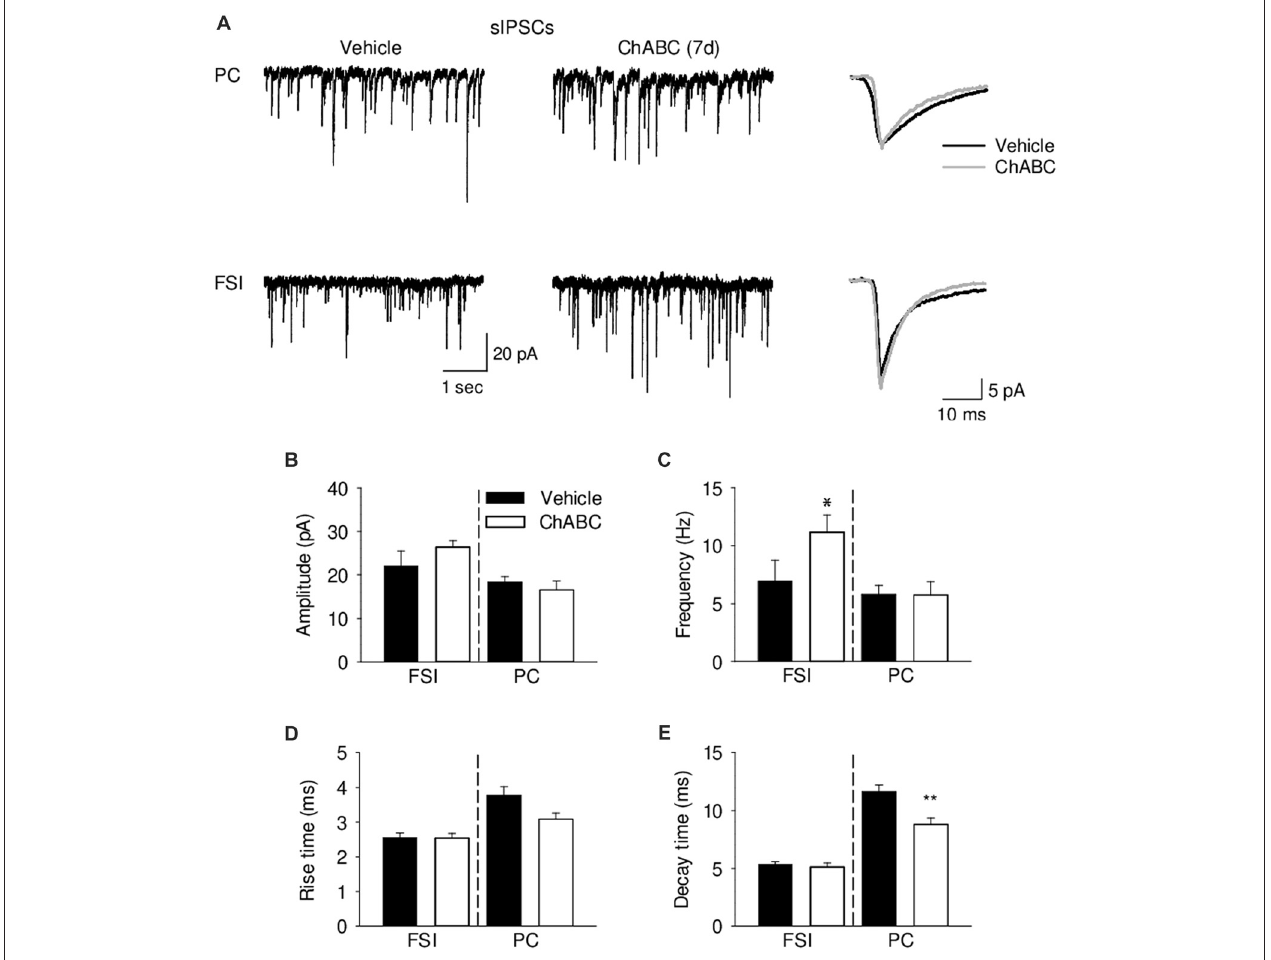
FIGURE 6 | Analysis of GABAergic transmission onto pyramidal neurons and fast-spiking interneurons 7 days (7 d) after ChABC injection. (A) Representative traces of sEPSC from CA2 pyramidal cells (upper) and FSIs (lower) in vehicle- and ChABC-injected hippocampal slices. Bar graphs of sIPSC amplitude (B) , frequency (C) , rise time (D) and decay time (E) of CA2 PCs and FSIs. Bars represent mean ± SEM in vehicle- (black) and ChABC-treated (white) FSIs (Vehicle, n = 9; ChABC, n = 14) and PCs (Vehicle, n = 14; ChABC, n = 10). ∗ P < 0.05, t -test after log-transformation to normalize distributions; ∗∗ P < 0.01, t -test, compared with